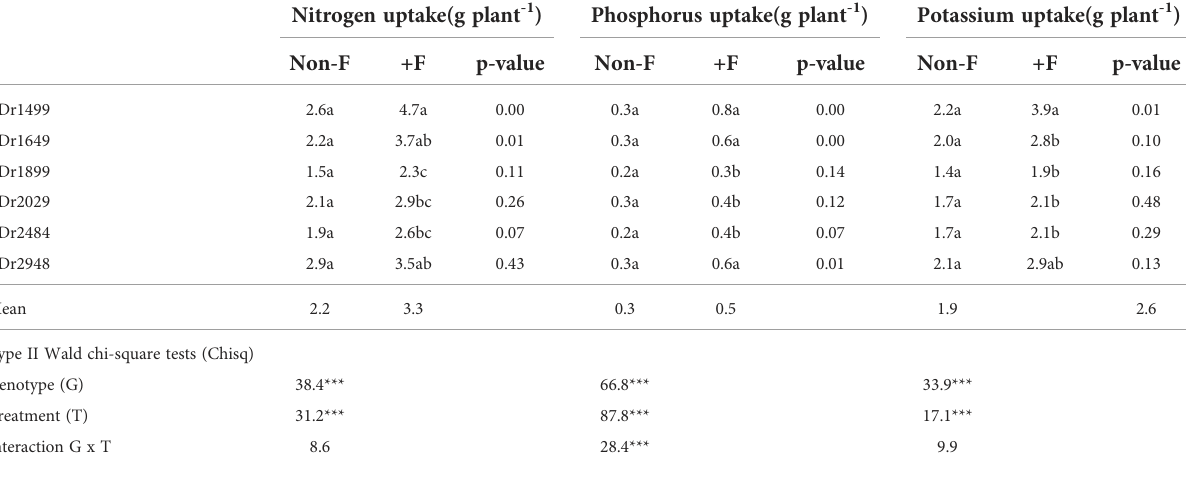
TABLE 5 Effect of genotype and fertilizer treatment on the uptake of nitrogen, phosphorus, and potassium in six white Guinea yam ( Dioscorea rotundata ) genotypes in the 2018